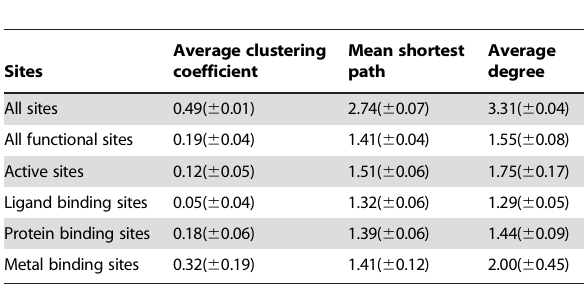
Table 4. Network properties of coevolved